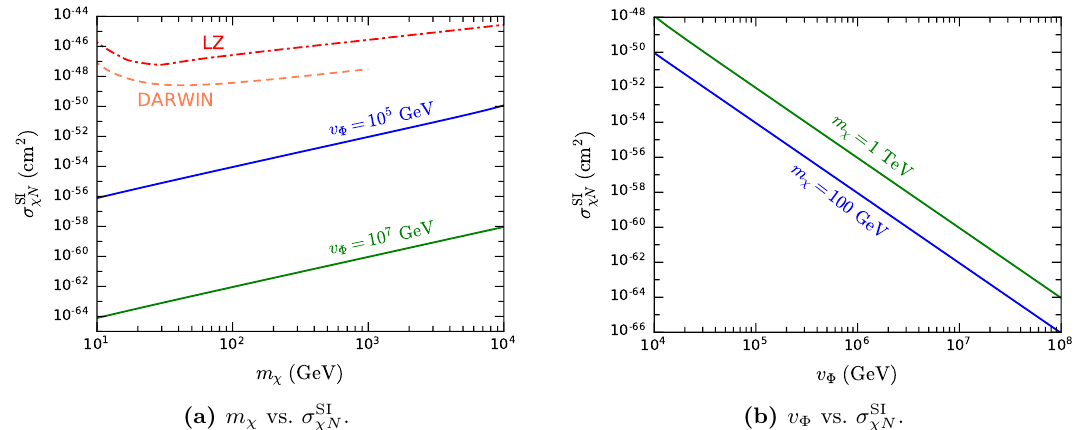
as functions of m (a) and v (b). The Figure 1. SI χ -nucleon scattering cross section σ SI χ Φ χN blue and green lines in the left (right) panel correspond to v = 10 5 GeV ( m = 100 GeV ) Φ χ and v = 10 7 GeV ( m = 1 TeV ), respectively. Other parameters are fixed as v = 1 TeV , Φ χ S = 300 GeV , m = 0 . 1 v , λ = 0 . 03 , and λ = λ = 0 . 01 . The left panel also shows the m h h 3 Φ HS H Φ S Φ 2 90% C.L. constraint from the LZ direct detection experiment [5] as well as the future sensitivity of the DARWIN experiment [47].